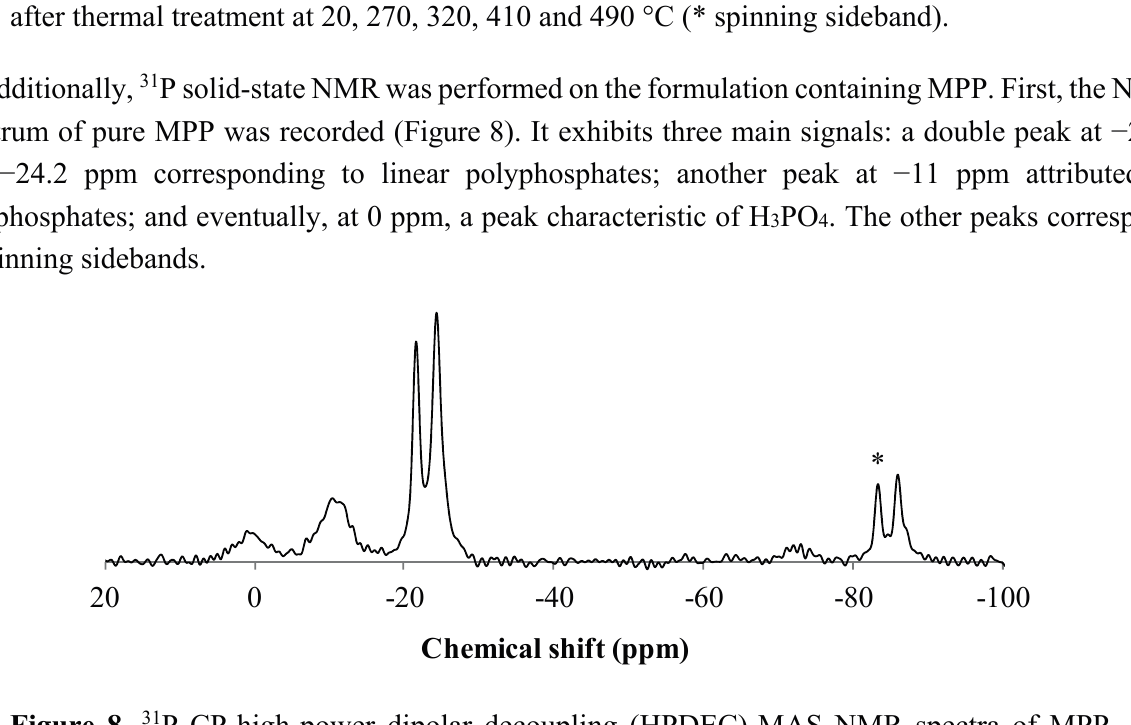
Figure 8. 31 P CP-high-power dipolar decoupling (HPDEC)-MAS NMR spectra of MPP (* spinning